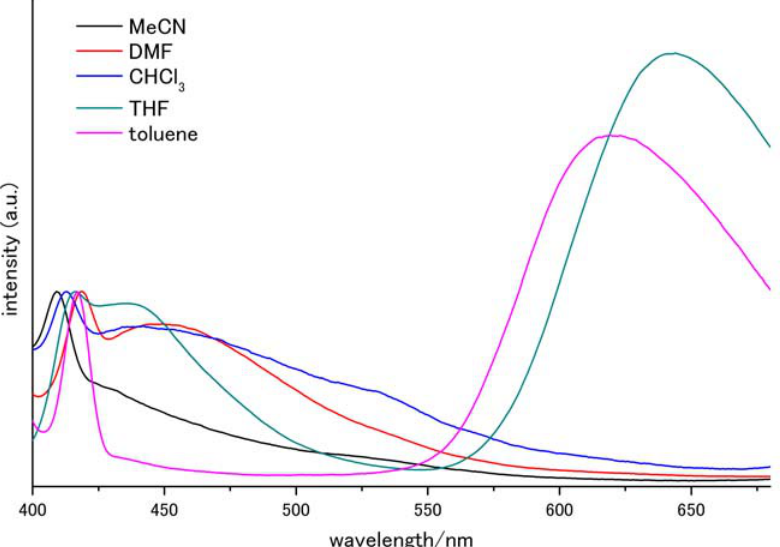
Figure 3. Fluorescence spectra in various